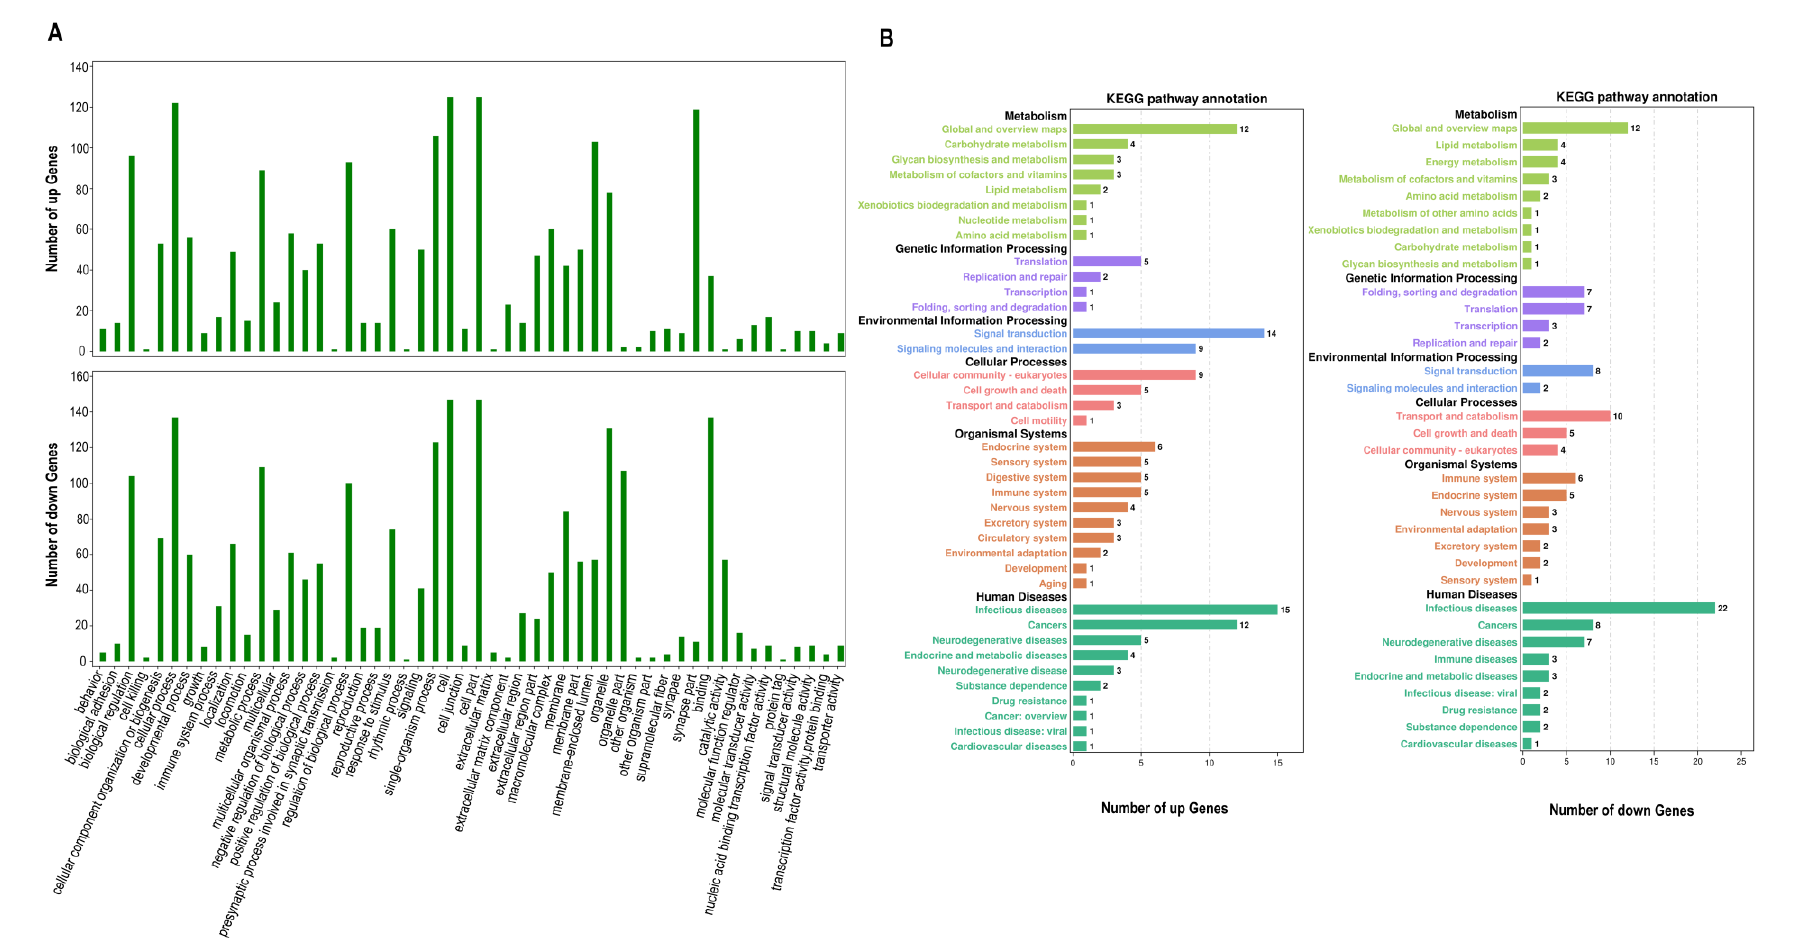
Figure 2. GO and KEGG pathway annotation of all DEGs. ( A ) GO annotation and classification of DEGs; ( B ) KEGG pathways in which DEGs were enriched (compared to the entire genome background). DEGs, differentially expressed genes. GO, gene ontology; KEGG, Kyoto Encyclopedia of Genes and Genomes.